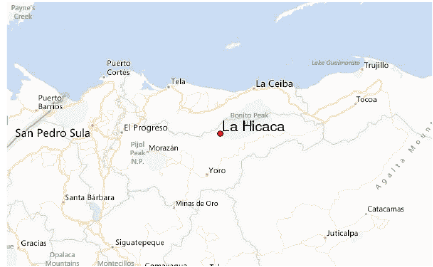
Figure 1: La Hicaca, Northern